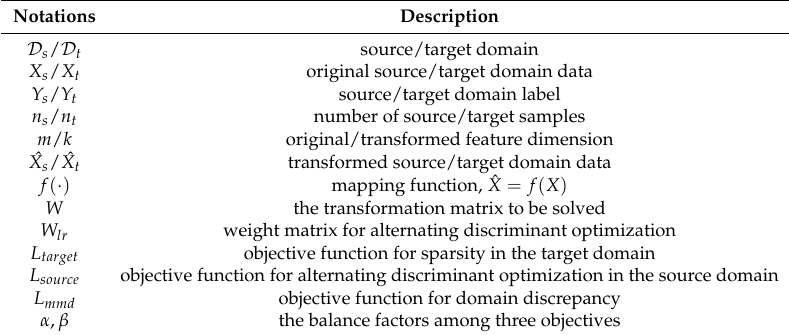
Table 1. Notations and descriptions used in this paper.